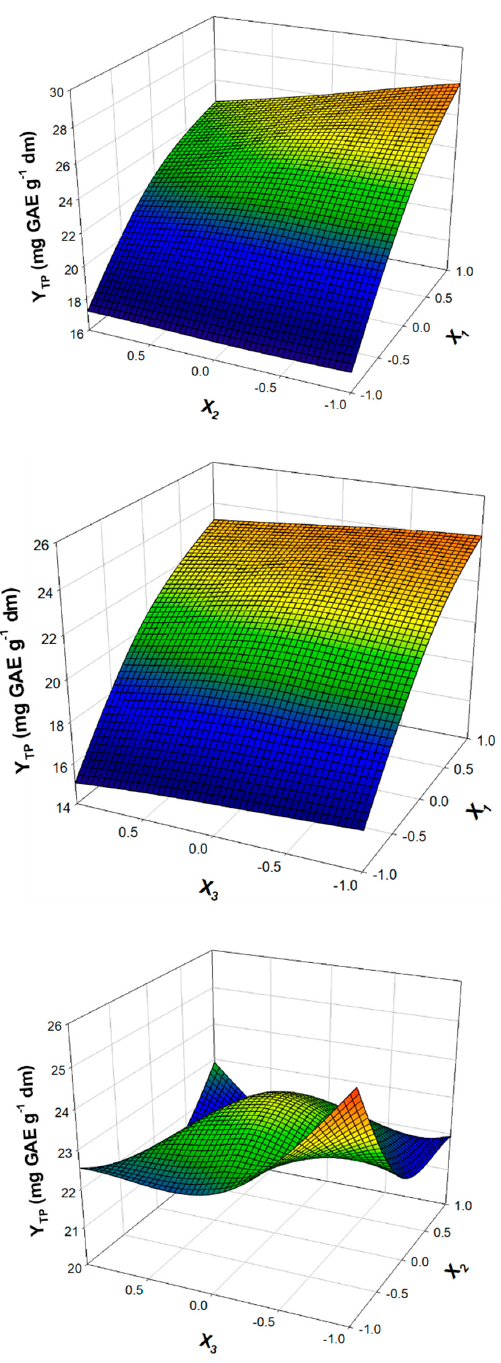
Figure 2. Visualization of the effect of independent variables on Y TP in the form of 3D